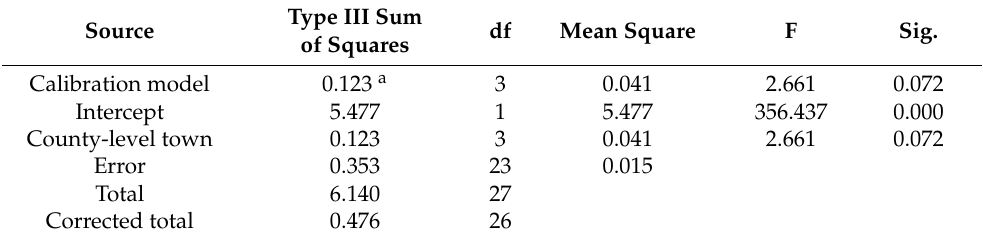
Table 12. One-way analysis of variance results table for middle and high schools. Type III Sum df Mean Square F Sig. Source of Squares Calibration model 0.123 a Intercept